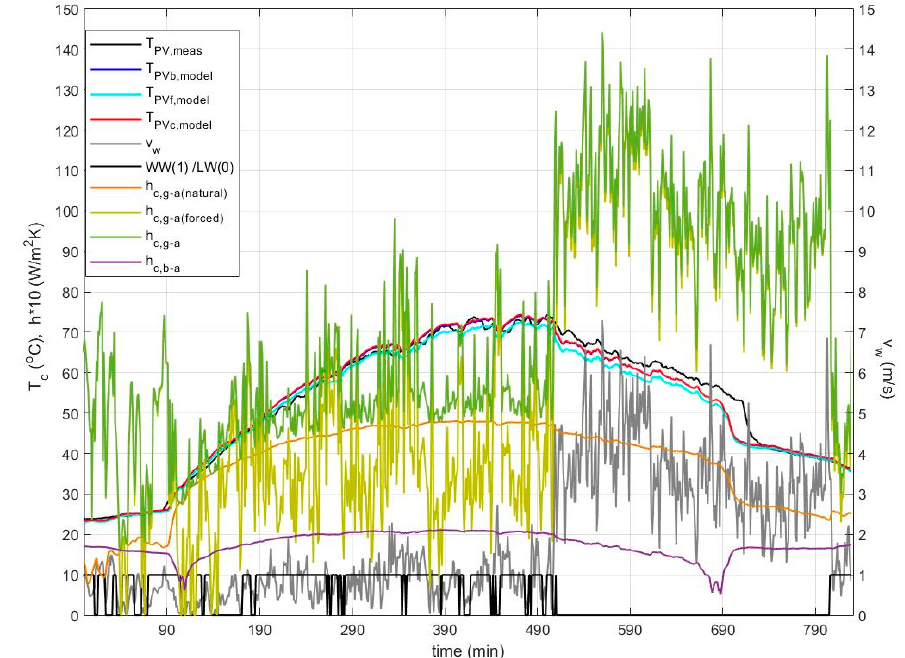
Figure 3. Predicted PV temperature profiles for the cell centre, the back surface and front glass cover by the proposed dynamic model compared to the measured temperature profile at the PV back surface of the BIPV system during 1 day in June, with time interval of 1 min. The convection coefficient profiles are also displayed along with the wind speed and an indication of whether the front side is windward (WW) or leeward (LW).